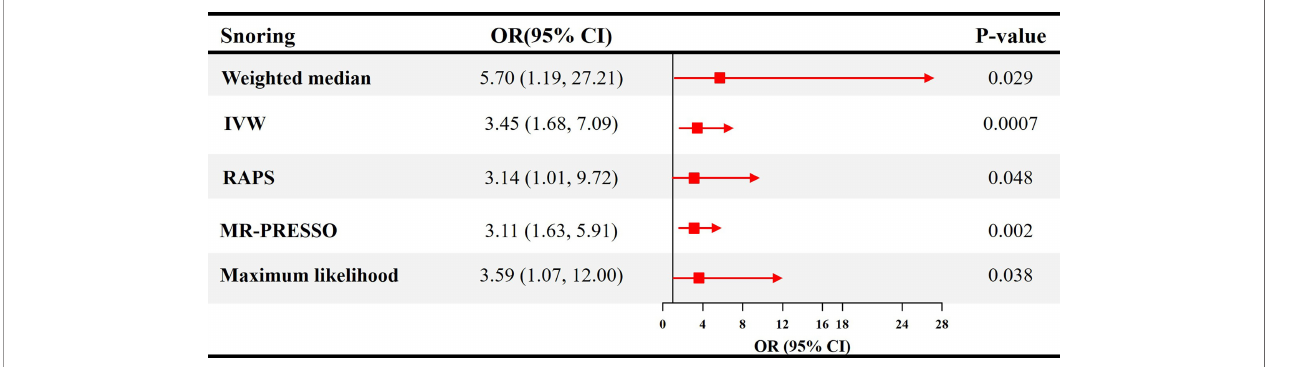
FIGURE 1 | Causal estimates of snoring on ED in SVMR. OR, odds ratio; CI, con fi dence interval; IVW, Inverse variance weighted method; RAPS, robust adjusted pro fi le score; MR, mendelian randomization; PRESSO, pleiotropy residual sum and outlier; ED, erectile dysfunction; SVMR, single-variable mendelian